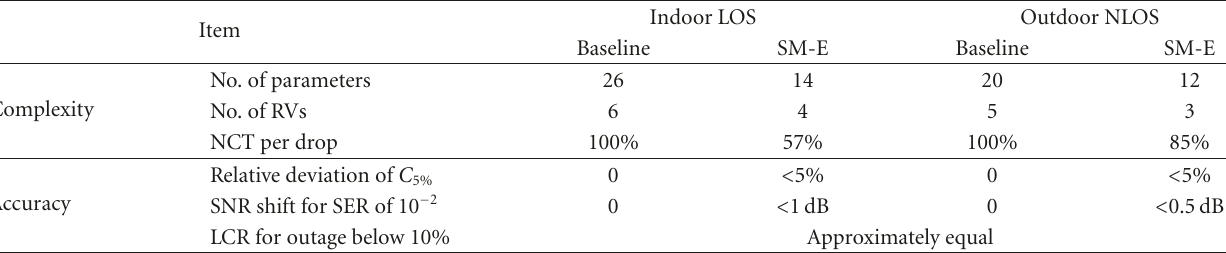
Figure 9: Level crossing rates of standardized MIMO capacity for baseline and simplified cases when ρ = 20dB. Table 6: Comparisons between the baseline model and SM-E